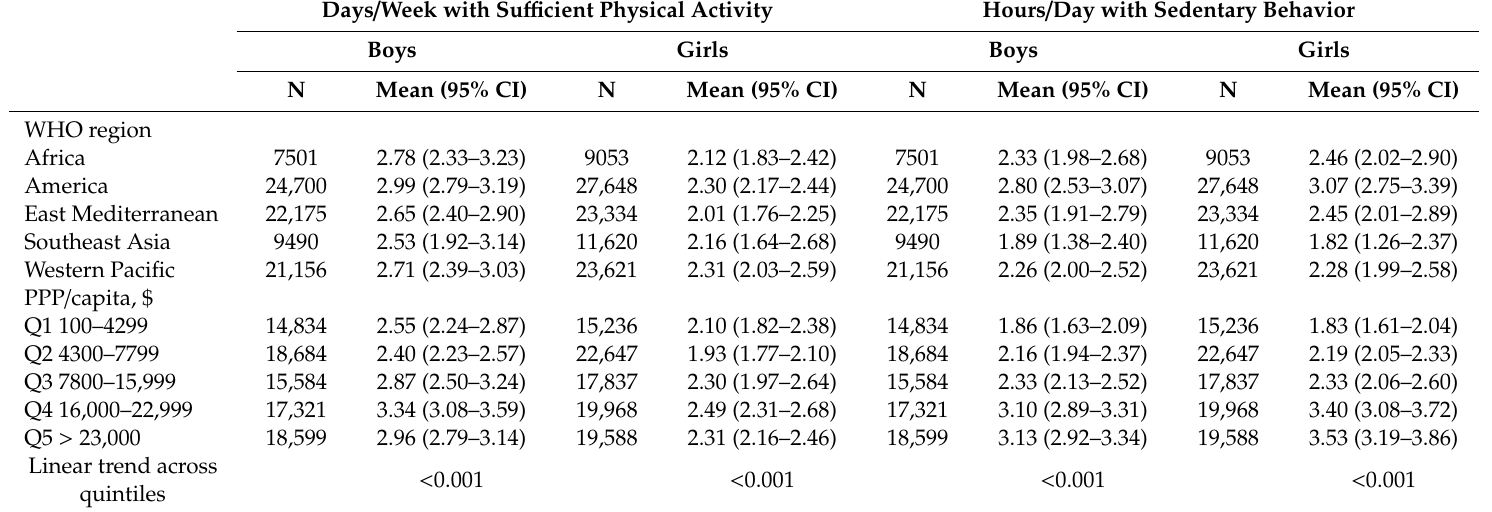
Table 1. Distribution of number of days / week with su ffi cient physical activity and number of hours / day with sedentary behavior in adolescents aged 12–15 years by sex, WHO region, and PPP